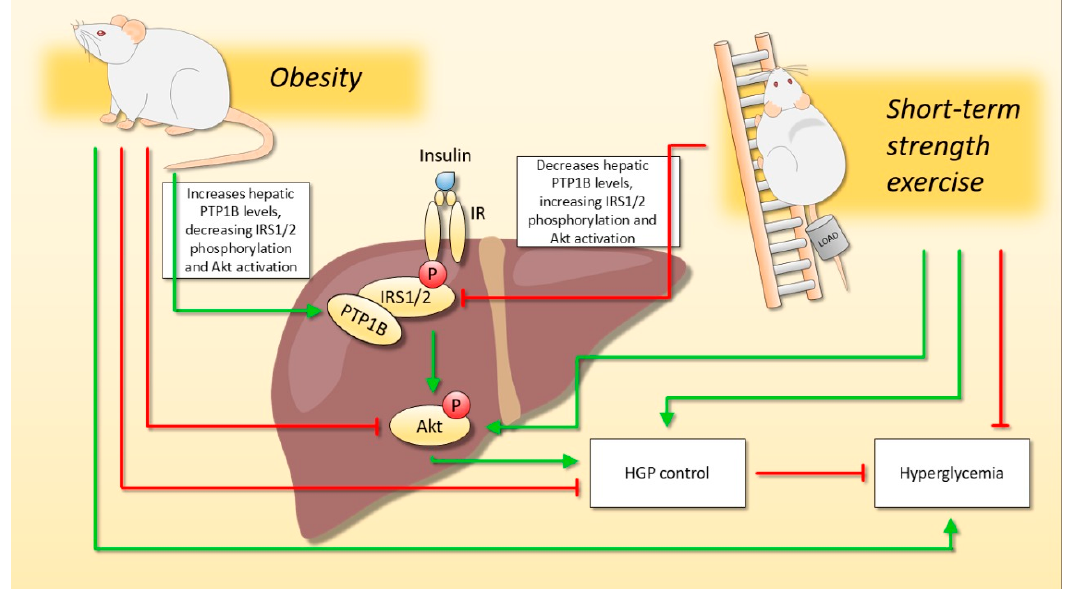
Figure 5. The effect of short-term strength exercise on hepatic glucose metabolism, regardless of body weight change. Diet-induced obesity impaired hepatic insulin signaling due to increased PTP1B content, which results in hyperglycemia and impaired control of hepatic glucose production (HGP). On the other hand, short-term strength exercise was able to reverse the harmful effects of obesity since exercised animals reduced the PTP1B content. Moreover, even though the exercised animals did not reduce body weight, the hepatic insulin signaling was improved, and they demonstrated better HGP control and reduced fasting glycemia.